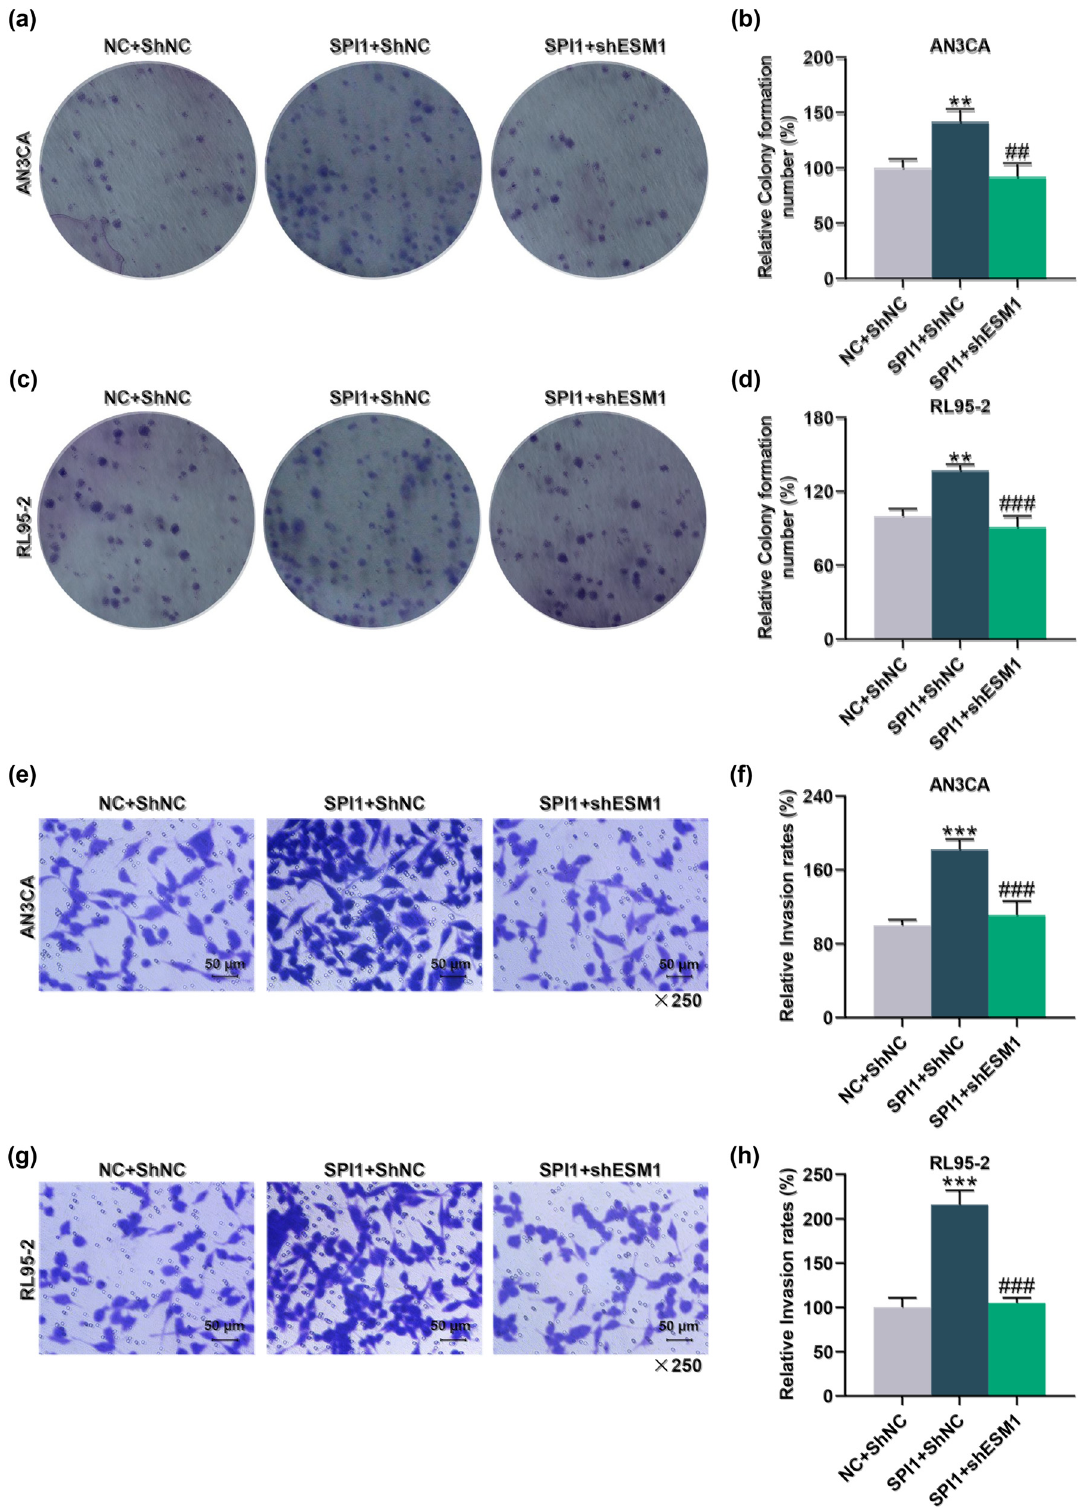
Figure 8: Silencing of ESM1 reversed the promotive e ff ects of SPI1 overexpression on the proliferation and invasion of EC cells. ( a – d ) Colony formation assay was applied to detect the e ff ects of SPI1 overexpression and ESM1 silencing on the colony - forming abilities of AN3CA and RL95 - 2 cells. ( e – h ) The invasion of AN3CA or RL95 - 2 cells in each group was detected by Transwell assay ( magni fi cation: × 250 times; scale bar: 50 µm ) . ** P < 0.01, *** P < 0.001 vs NC + ShNC; ## P < 0.01, ### P < 0.001 vs SPI1 +